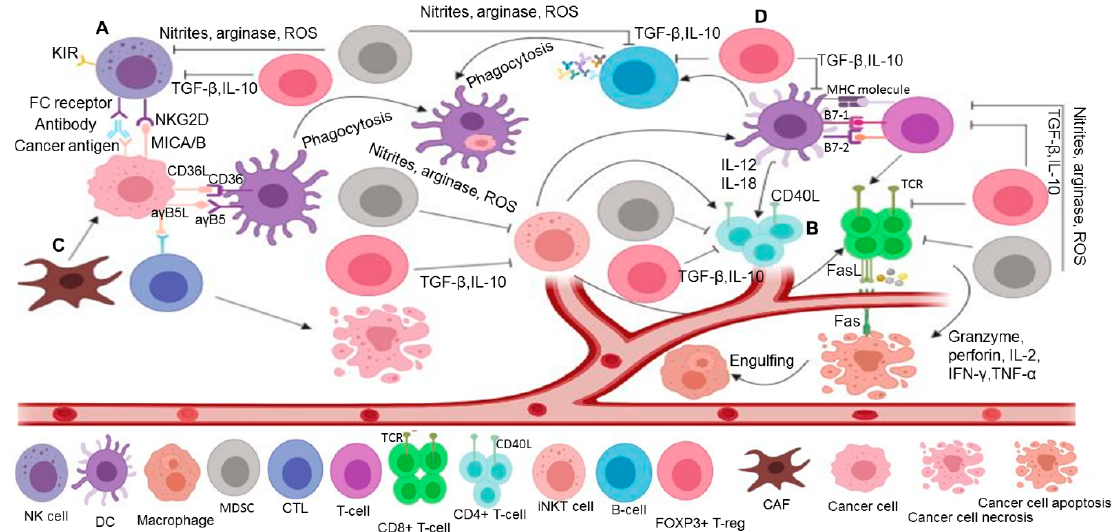
Figure 4. The role of immune cells in cancer development. ( A ) NK cells are the first line of innate immunity, activated by NKG2D and CD16 (Fc receptor) to promotes cancer cell killing through an antibody dependent cell-mediated cytotoxicity (ADCC effect). ( B ) The activation of CD4 + T cells, CD8 + T cells and B cells promotes phagocytosis of cancer cells by dendritic cells and macrophages through Fas/FasL, granzymes, perforins, interleukin-2 (IL-2), tumor necrosis factor (TNF- α ), and interferon – γ (IFN- γ ). ( C ) Cancer associated fibroblast (CAF) provides support for cancer cells to promotes immune escape. ( D ) By contrast, these anti-tumor function is counteracted by the presence of fork head box P3 (FOXP3 + ) T regs (regulatory T cell) and myeloid-derived suppressor cells (MDSC) through production of TGF- β , IL-10, arginase, nitrites and ROS.